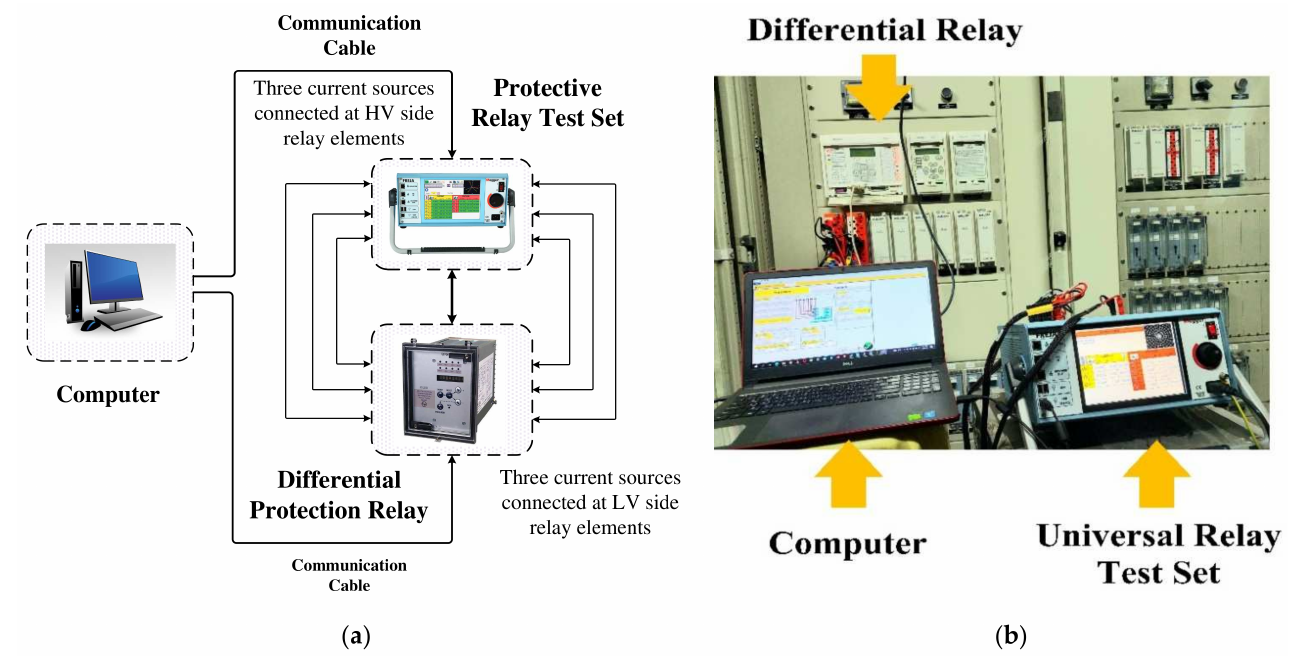
Figure 5. Test bench with differential relay, test set, and computer: ( a ) schematic diagram, ( b ) pictorial view of hard- ware setup.